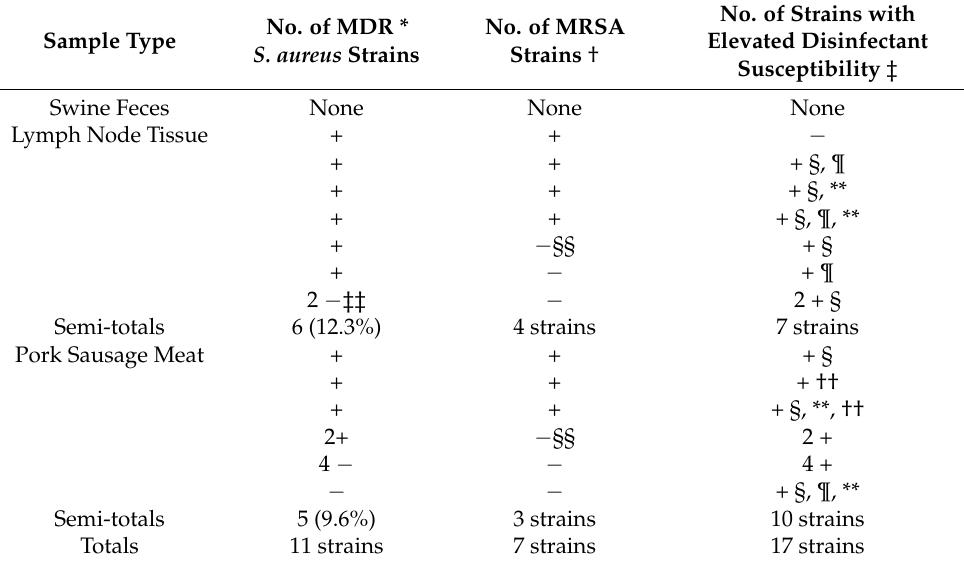
Table 6. Correlation between MDR and MRSA strains and strains showing elevated disinfectant susceptibility isolated from swine feces, swine mandibular lymph node tissue, and commercial